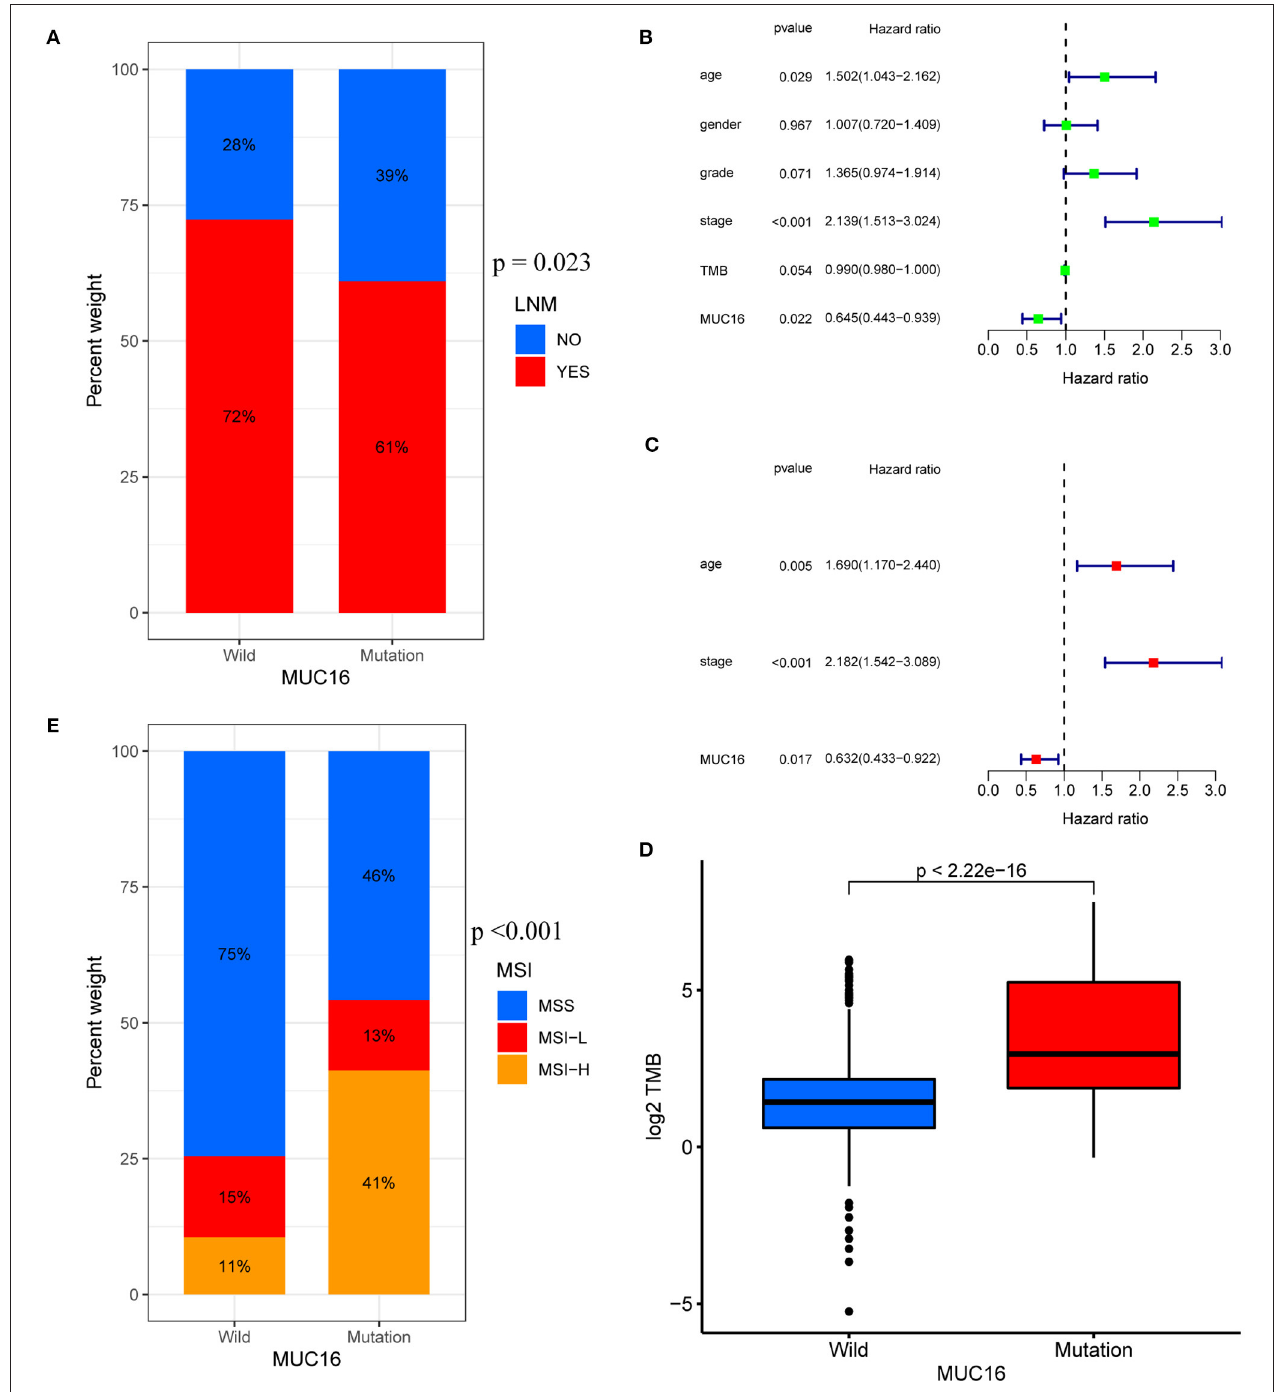
FIGURE 4 | Associations between MUC16 mutation status and clinicopathological characteristics in TCGA-STAD cohort. (A) Proportions of patients with LNMs in MUC16 mutations. (B,C) Univariate and multivariate Cox regression analyses of independent risk factors. (D) Relationship between TMB and MUC16 mutation. (E) Association between MUC16 mutation status and MSI. MSI, microsatellite